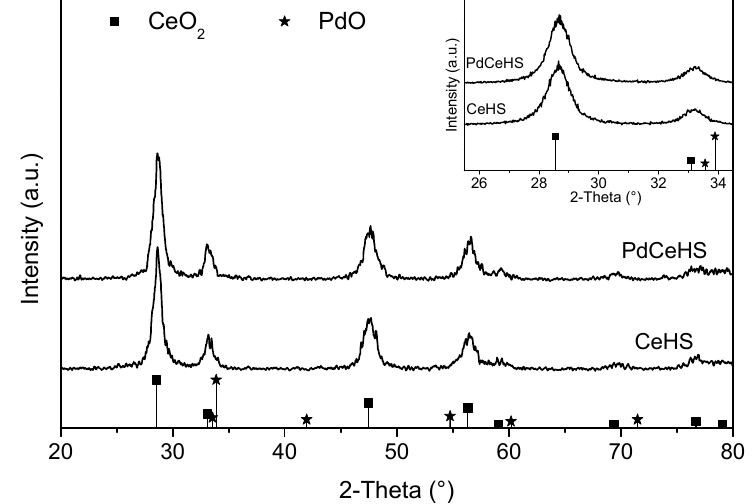
Figure 1. XRD analysis Pd-CeO 2 catalyst powder. The detail reports a magnification of CeHS and PdCeHS diffractograms in the 25.5–34.5° 2 θ region.